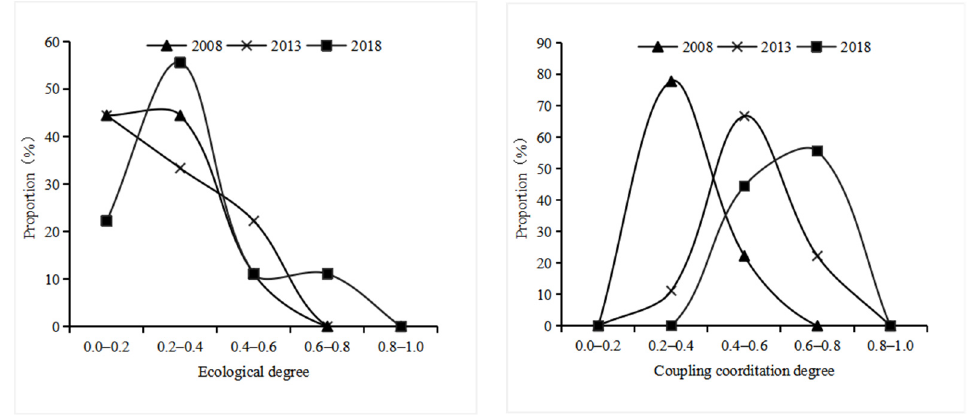
Figure 4. Evolutionary trend of the functional proportion of different regions in the Yellow River Basin.